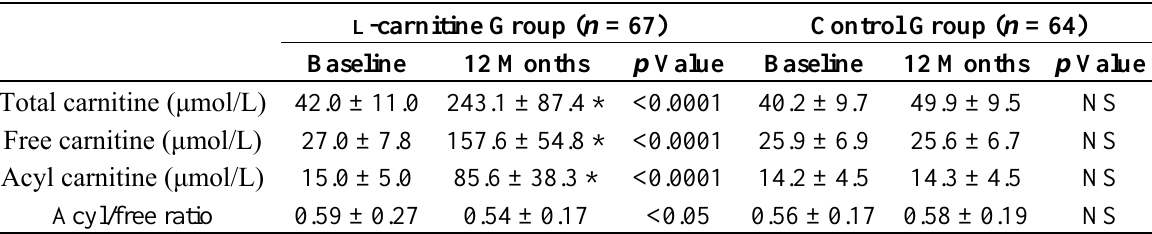
Table 3. Changes in L -carnitine concentration during the treatment period. L -carnitine Group ( n = 67)